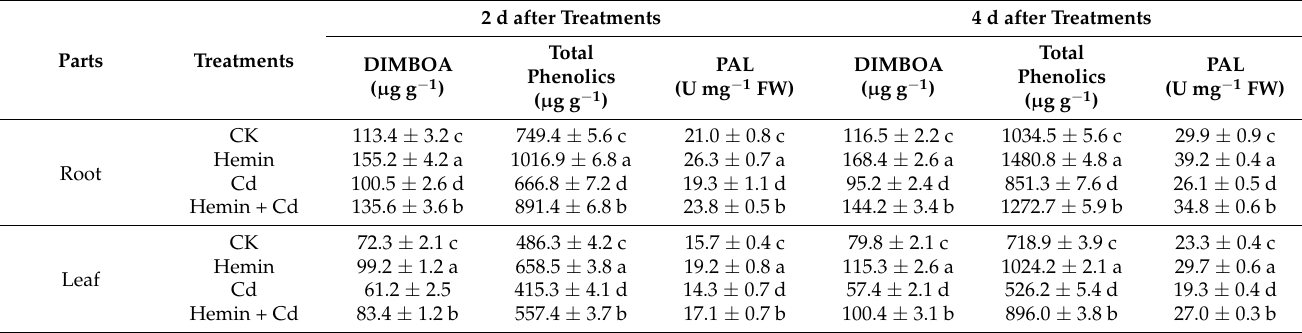
Table 7. Effects of hemin on 2,4-dihydroxy-7-methoxy-1,4-benzoxazin-3-one (DIMBOA) and total phenolic contents and phenylalanine ammonia lyase (PAL) activity in roots and shoots under Cd